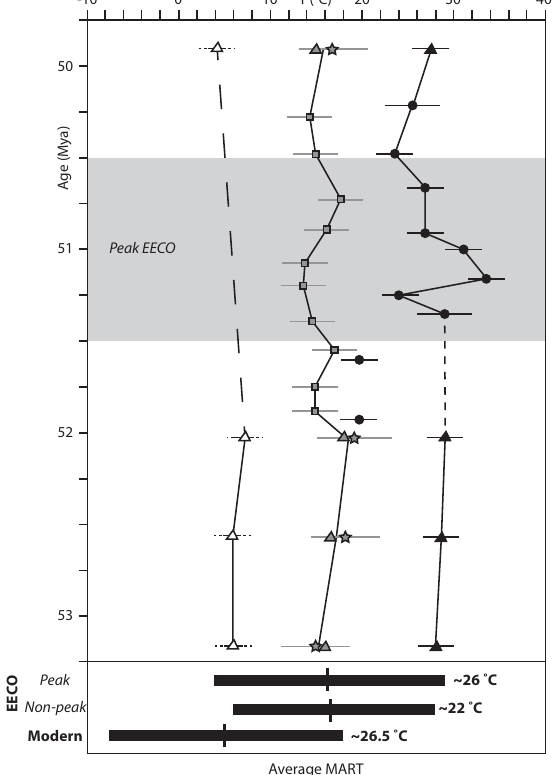
Figure 4. Temperature proxy estimates of CMMT (white plot), MAT (gray plot), and WMMT (black plot) through the early Eocene. Triangles represent paleobotanical coexistence estimates, squares represent paleosol geochemistry estimates, stars represent revised paleobotanical physiognomy estimates, and circles rep- resent clumped isotope estimates. Error bars represent probabil- ity density function 2 σ (paleobotanical coexistence), root mean squared error (PPM 1 . 0 paleosol geochemistry), calibration stan- dard error (paleobotanical physiognomy), and propagated analyt- ical and calibration error (clumped isotopes). Shading highlights peak EECO conditions based on previous work (e.g., Hyland et al., 2017), the long dashed line highlights possible aliasing due to a long sampling interval, and the short dashed line highlights exclusion of two clumped isotope data points (see Discussion). Estimates of peak EECO (51 ± 0 . 5Ma) and non-peak EECO MART are defined as de- scribed in Table 1 and the Discussion, with MAT shown by vertical lines. Modern MART and MAT are from averaged climate normals for NOAA weather stations in the GRB (NCDC, 2010).